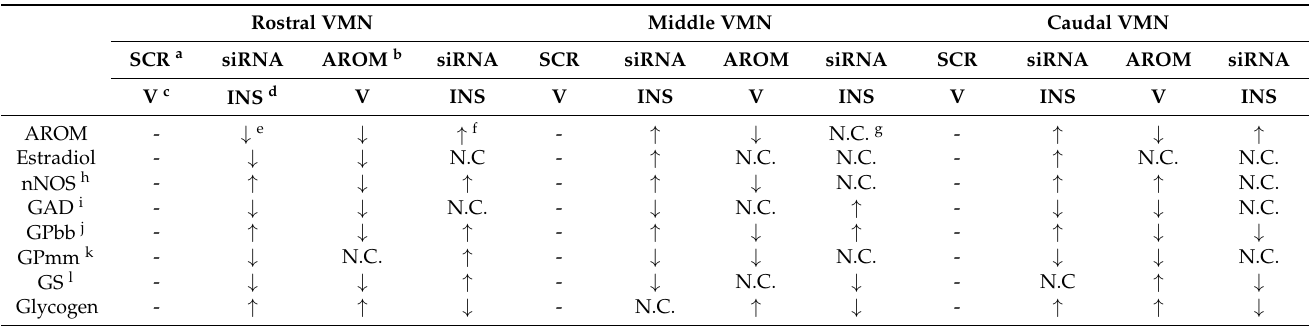
Table 1. Summary of Ventromedial Hypothalamic Nucleus (VMN) Aromatase Gene Knockdown Effects on Glucose-Regulatory Transmitter Marker and Astrocyte Glycogen Metabolic Enzyme Protein Expression in Rostral, Middle, versus Caudal